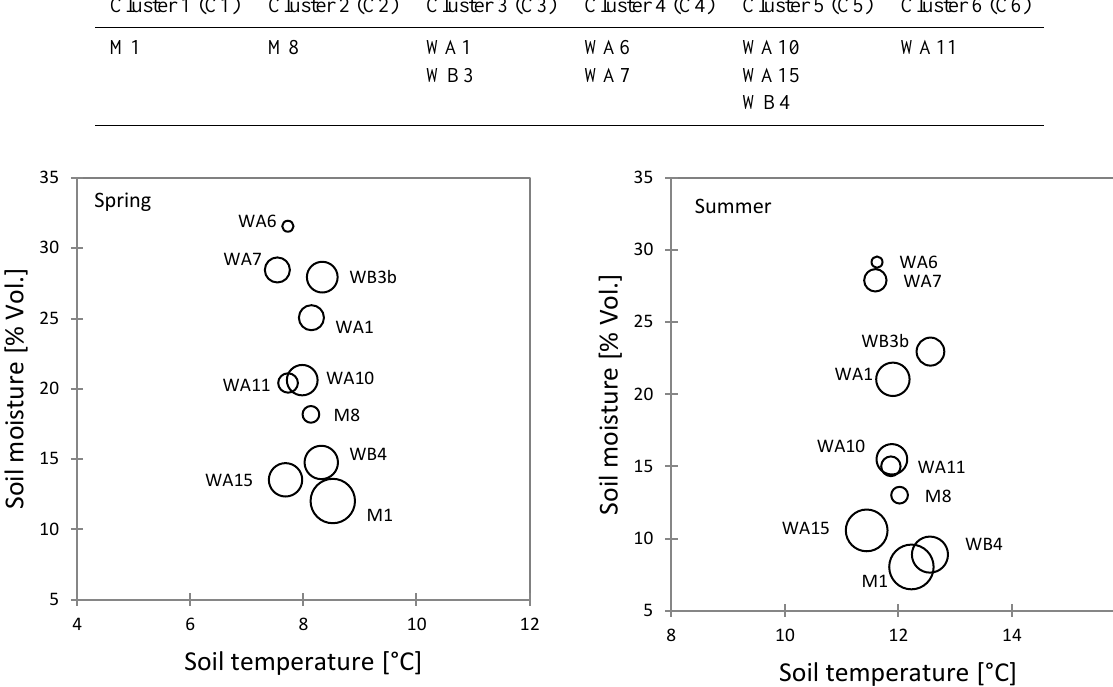
Figure 2. 2-D plot of CO 2 efflux dependency on soil temperature and soil moisture and likely clustering based on average values observed from 2011 to 2012. The circle sizes indicate the rate of CO 2 efflux at a given